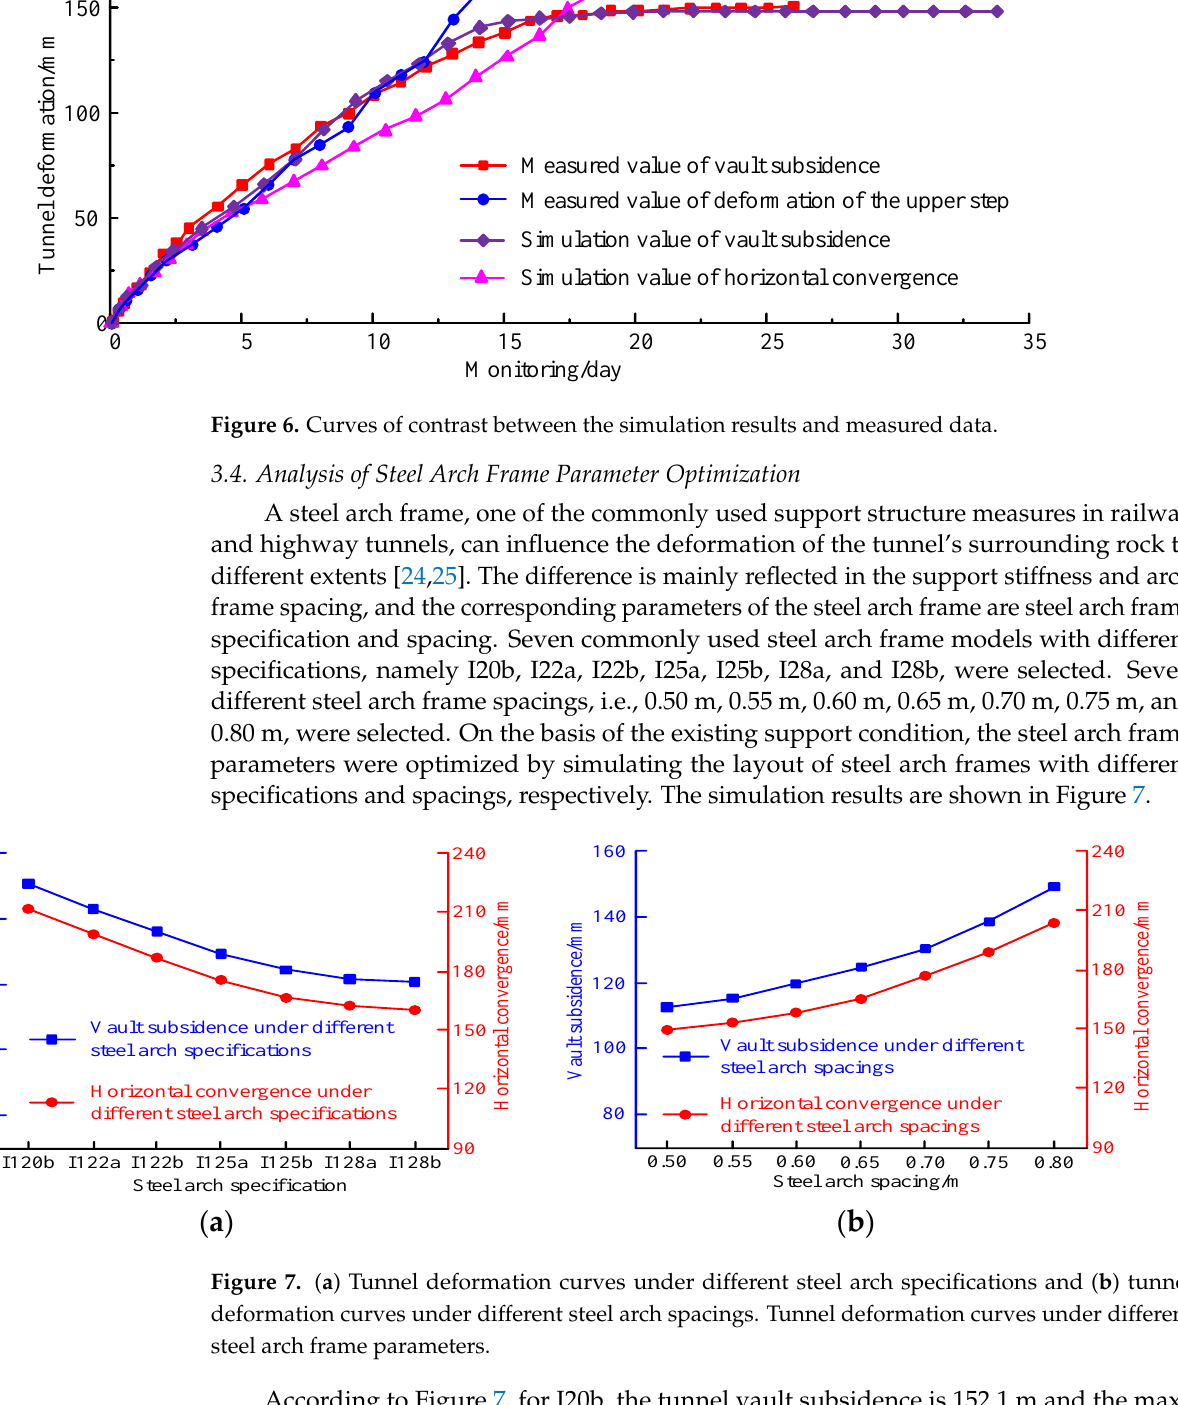
7 of 12 Figure 5. ( a ) Nephogram of vertical displacement and ( b ) nephogram of horizontal displacement. Nephograms of the displacement of the rock surrounding the tunnel . The numerical simulation results of the original initial support scheme were contrasted with the on-site measured data (Figure 6). It can be seen from Figure 6 that the numerical simulation results vary in a similar trend to the actual on-site measured data